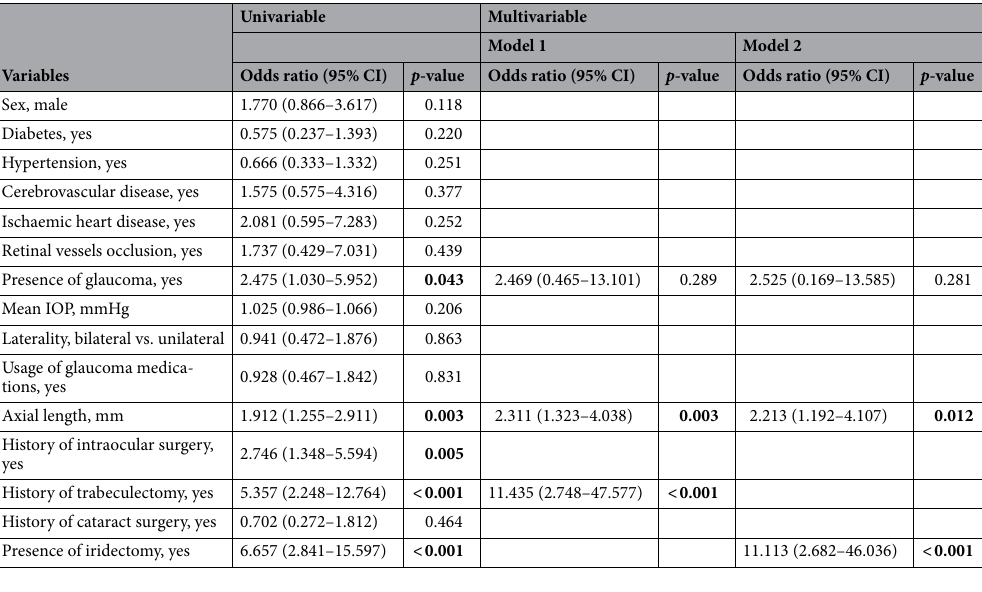
Table 2. Factors associated with early-onset XFS using logistic regression analysis. The history of trabeculectomy and the presence of iridectomy were strongly associated with each other; thus, each was analysed separately in the multivariate analysis. CI, Confidence interval; IOP, intraocular pressure; XFS, exfoliation syndrome. Statistically significant values are shown in